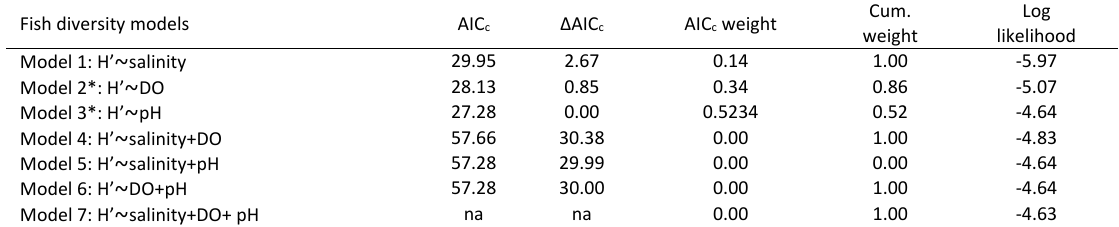
Table 3: AIC models of fish diversity (H’) with H’, DO, salinity, and pH variables at intact and disturbed sites on West Java coast Fish diversity models